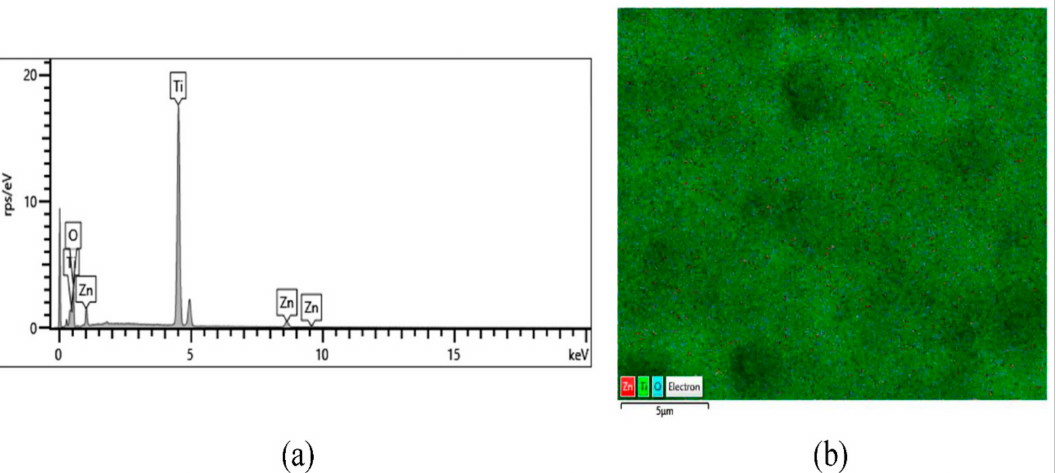
Figure 9. EDX analysis of the TiO 2 /ZnO hybrid nanosponges electrodeposited for 15 min at 75 ◦ C with 10 mM Zn(NO 3 ) 2 concentration on crystalline TiO 2 : ( a ) EDX spectrum of elements and ( b ) EDX mapping of the surface differentiating elements by colours.